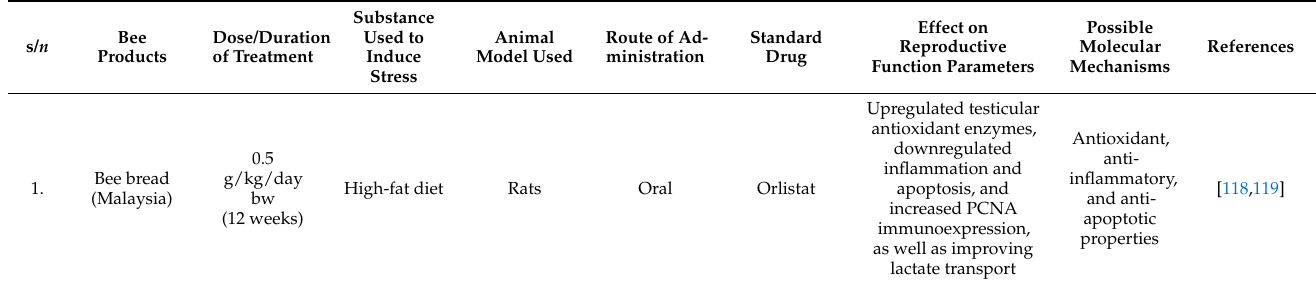
bw: body weight; PCNA: Proliferating cell nuclear antigen.